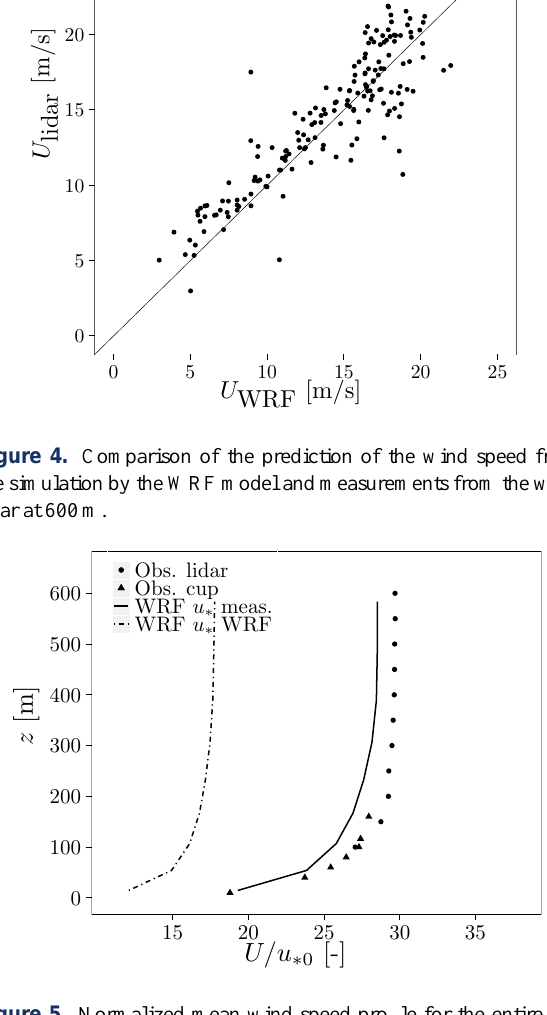
Figure 3. Comparison of the prediction of the wind speed from the simulation by the WRF model and measurements from the wind lidar at 100m.